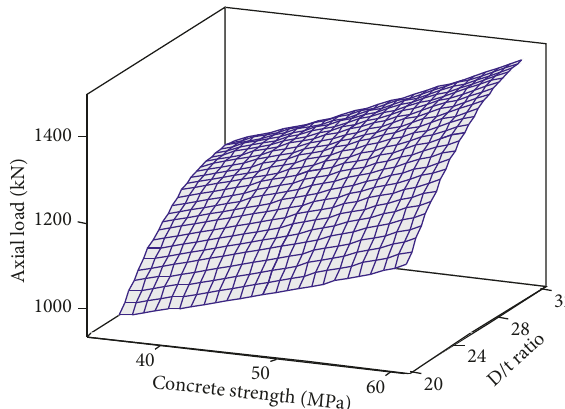
Figure 6: Surface plot examination of the effect of D/t ratio and concrete strength on column strength.